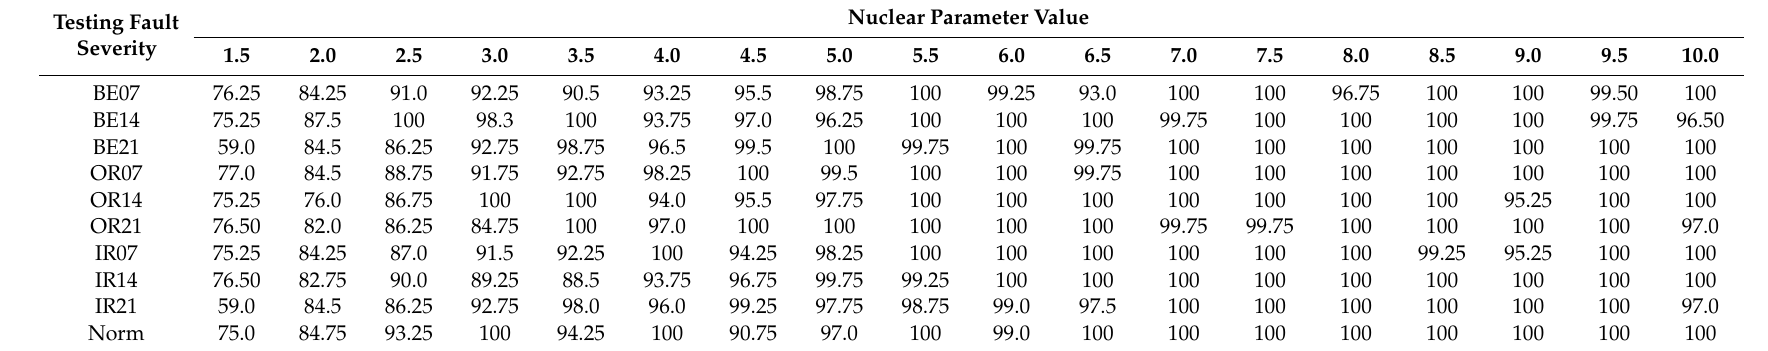
Table 12. The influence of nuclear parameter selection of the mRVM on fault identification accuracy of the rolling bearing (%). Testing